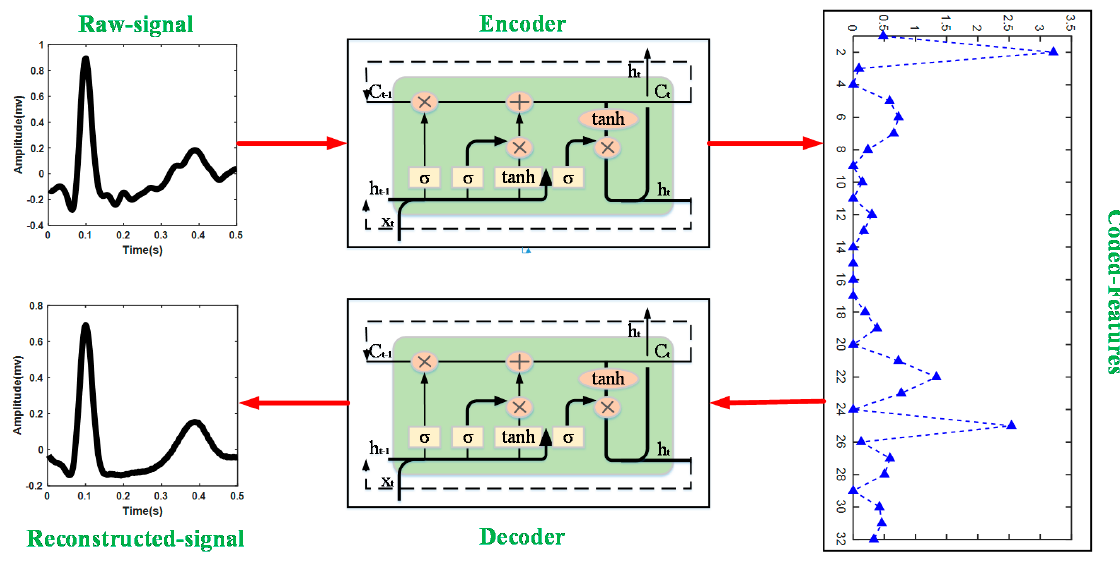
Figure 2. Structure of LSTM-AE in this study.